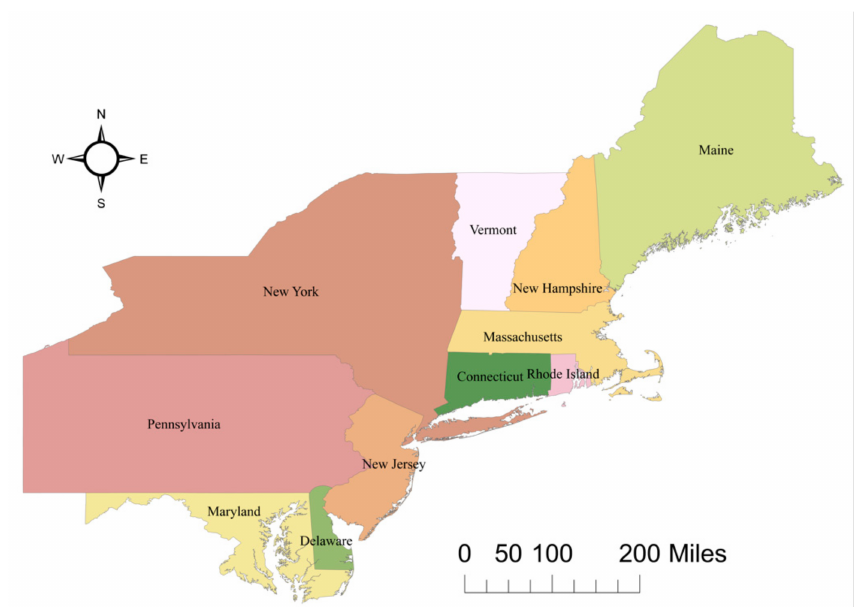
Figure 5. Map of the 11 states in the United States of America considered in our